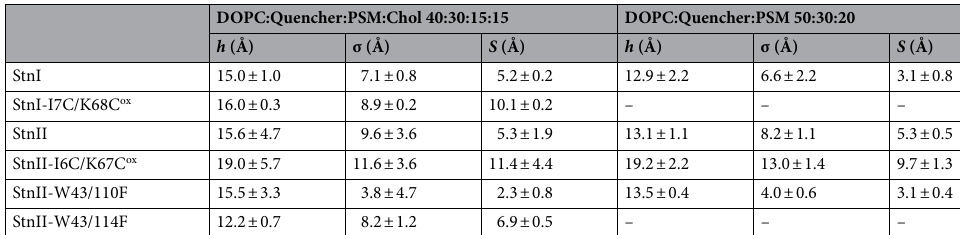
Table 3. Fitting results of the depth-distribution analysis. Values were obtained from fitting Eq. 6 to the quenching results shown in Fig. 4. Parameters are average depth ( h ), width of the distribution (σ), and area ( S ), related to fluorophore accessibility. Indicated data for StnII-W43/110F in presence of Chol were obtained using data from Chol-lacking membranes as guidance since the initial fit was unsuccessful. Data shown for StnII- W43/114F are from the dashed line fit in Fig. 4. However, results are very similar for the fit shown with solid